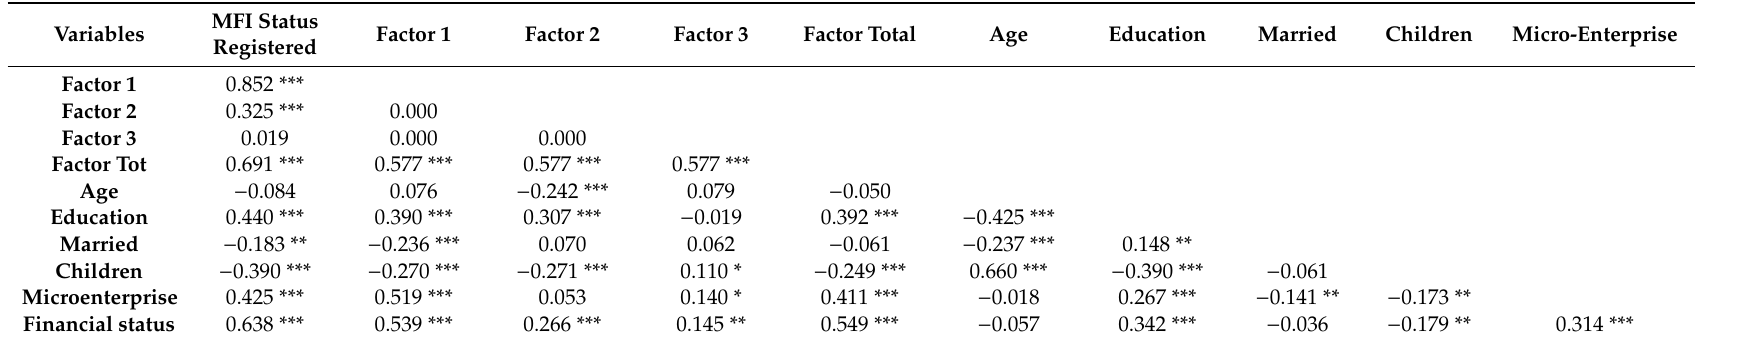
Table 5. Pearson’s correlations (N = 342).